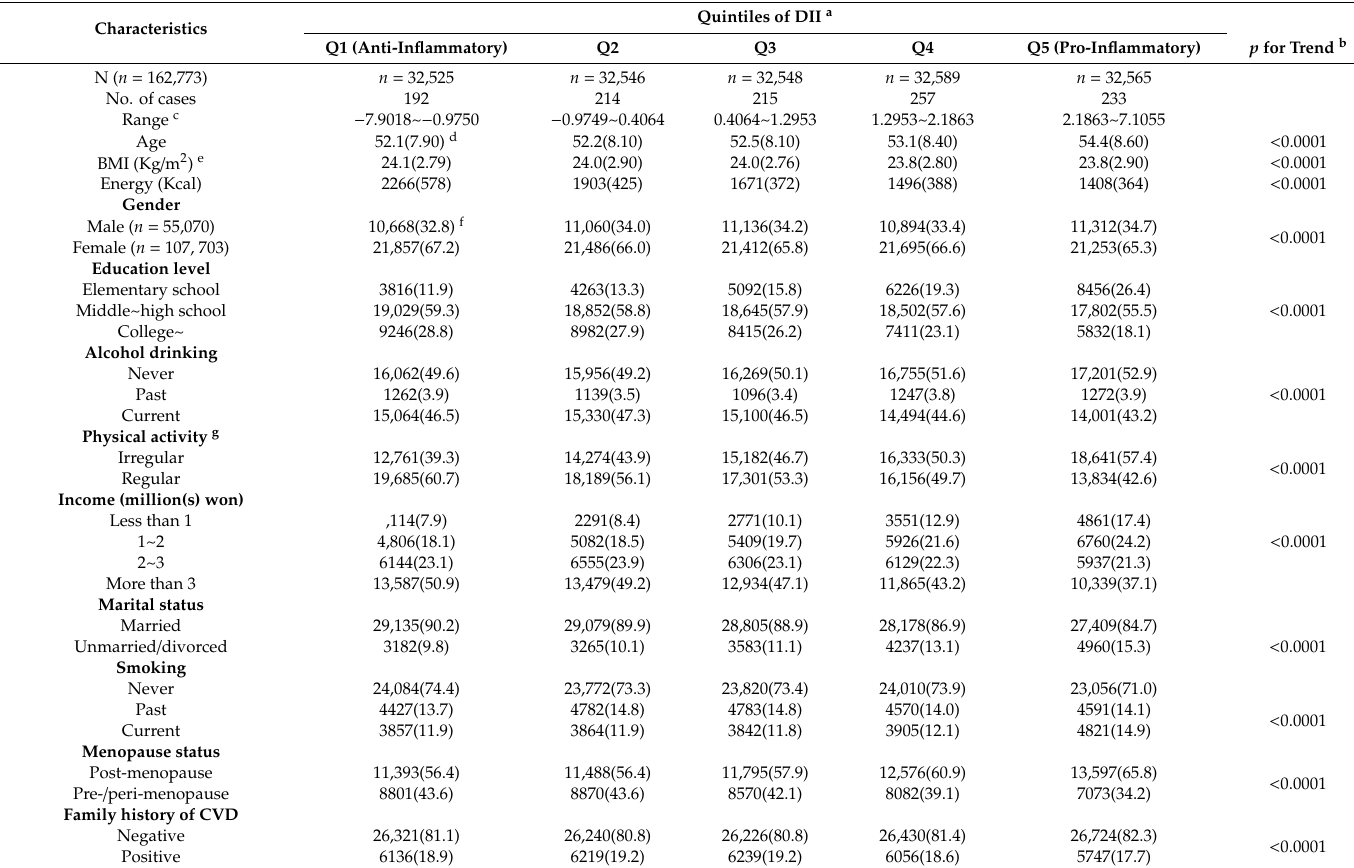
Table 1. Baseline characteristics of the study subject by dietary inflammatory index (DII) quintiles in the KOGES_HEXA cohort, 2004~2013.